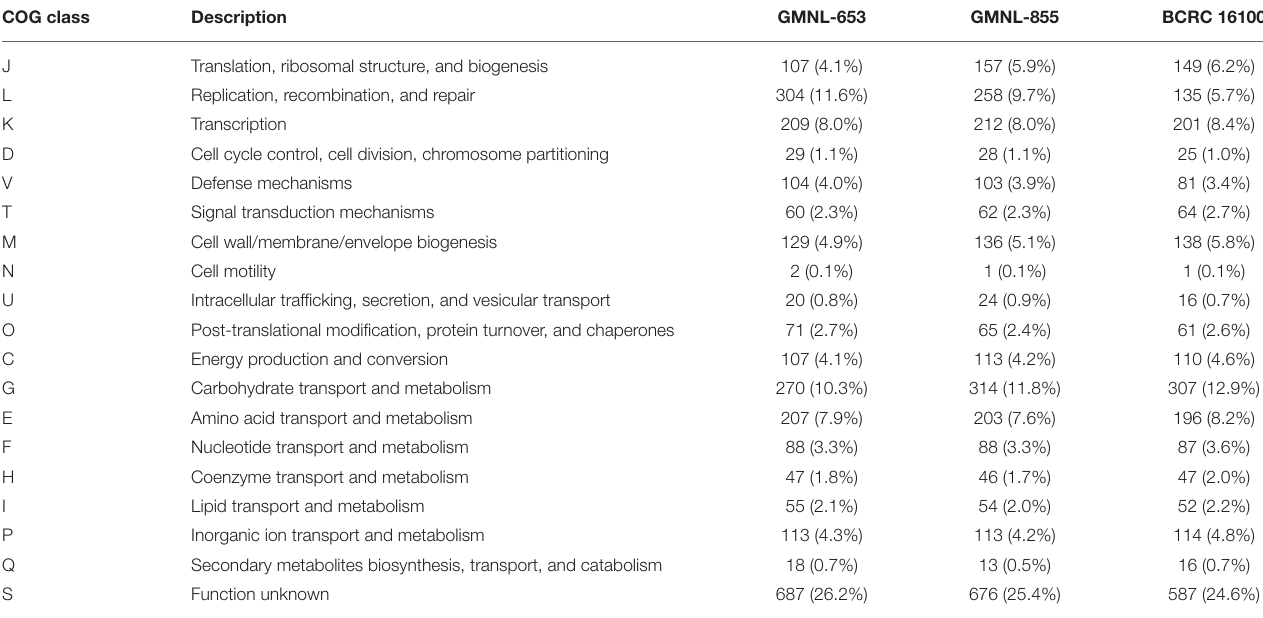
TABLE 3 | COG functional categories of L. paracasei